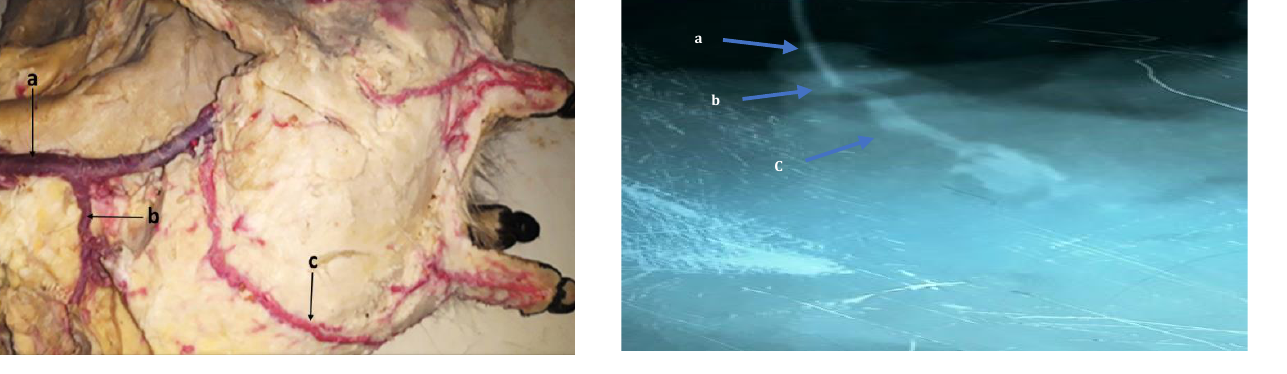
Figure 7. Radiographic picture of the fore quarter in non-lactating udder. (4 mL of Iopromide contrast media) shows: (a) The teat orifice, (b) The